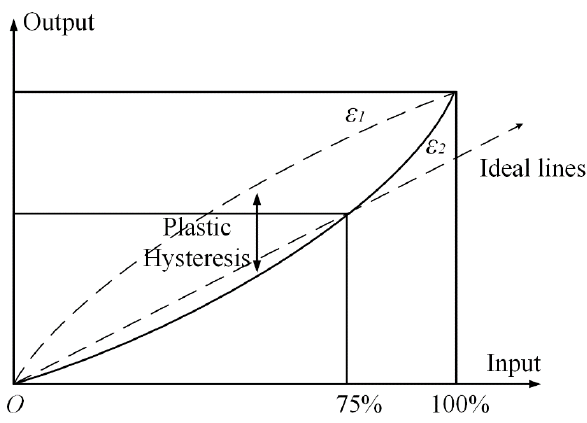
Figure 9. Schematic diagram of hysteresis effect.